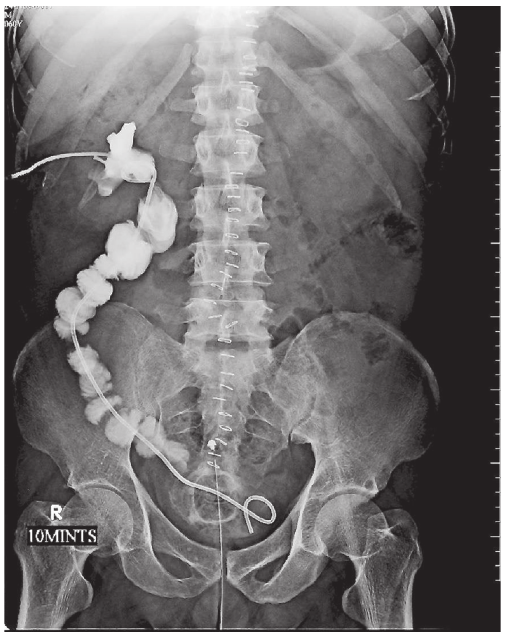
Figure 4: Classic ileal replacement done after 3 weeks. Neph- rostogram with adequate